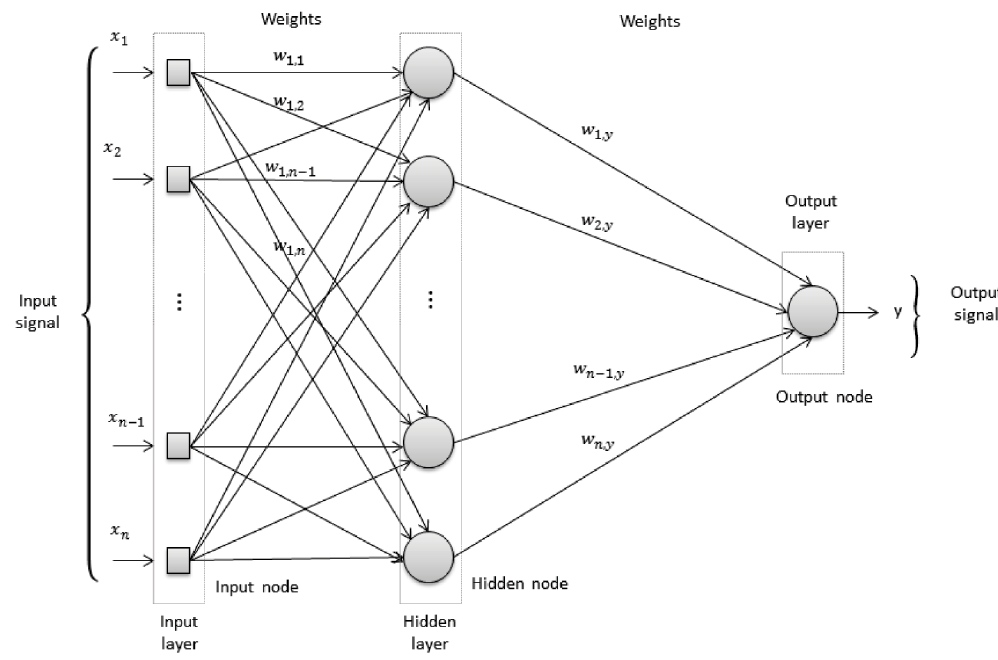
Fig. 1. Neural-network feedforward structure. x i represents the n th input unit, and y represents the output